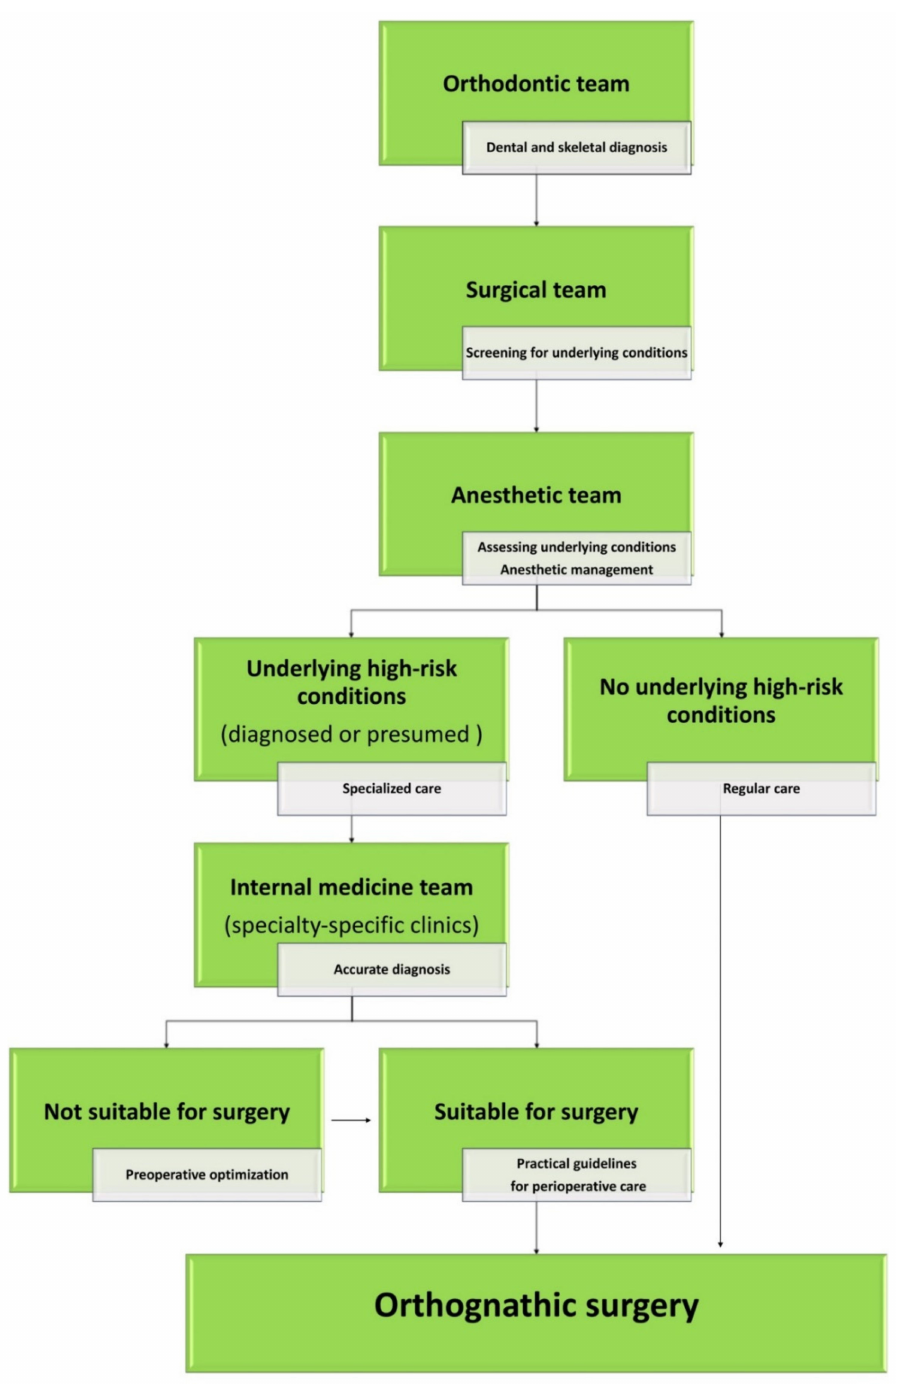
Figure 2. Multidisciplinary orthognathic surgery team-based approach. For patients without underlying high-risk conditions (regular-risk group), preoperative assessment (general and surgically focused history, physical examinations, and recommendations based on the American Society of Anesthesiologists Physical Status (ASA-PS) scores) conducted by the surgical and anesthetic teams are typically su ffi cient. For patients receiving diagnosed or presumed underlying high-risk conditions (high-risk group), specialty-specific consultations are required. Based on an accurate diagnosis (including complementary tests), patients may have their orthognathic surgery programmed or a preoperative optimization may be required before surgery. Condition-specific guidelines with practical recommendation for perioperative care are provided by the medical specialist